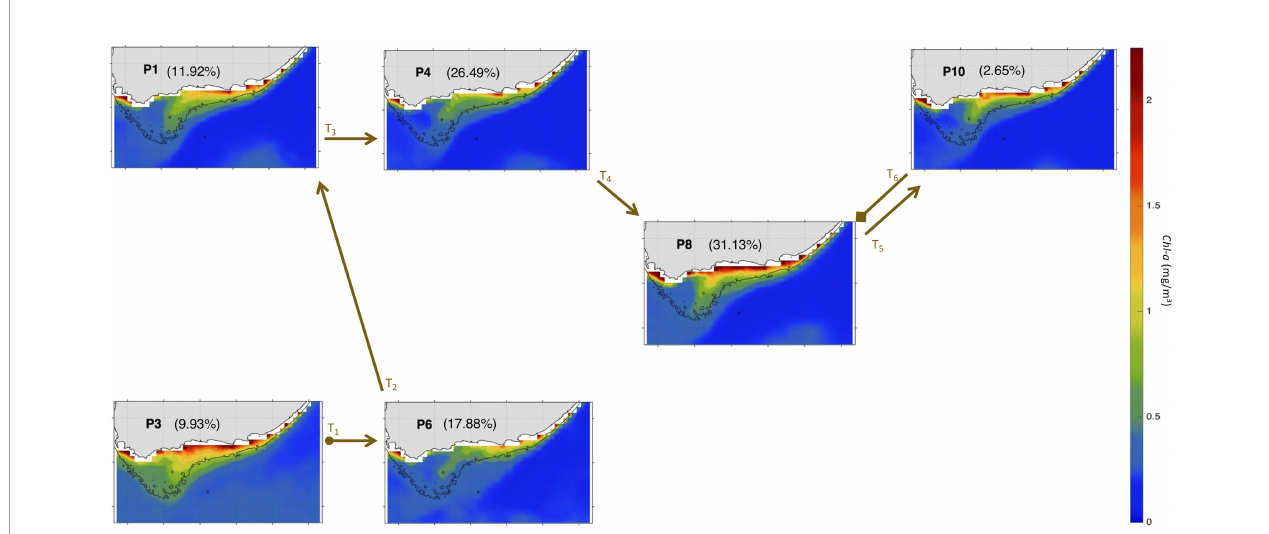
FIGURE 11 | Same as Figure 4 but for Nov-Mar 2005-06. The frequency of occurrence of each pattern is calculated here relative to the days recorded during Nov-Mar 2005-06. The brown arrows represent the SOM patterns trajectories (T i=1:6 ) evolving during Nov-Mar 2005-06 as inferred from the BMU timeseries ( Supplementary Figure 4A ). The starting ( fi nal) trajectory is designated with a circle (diamond) at the arrow beginning